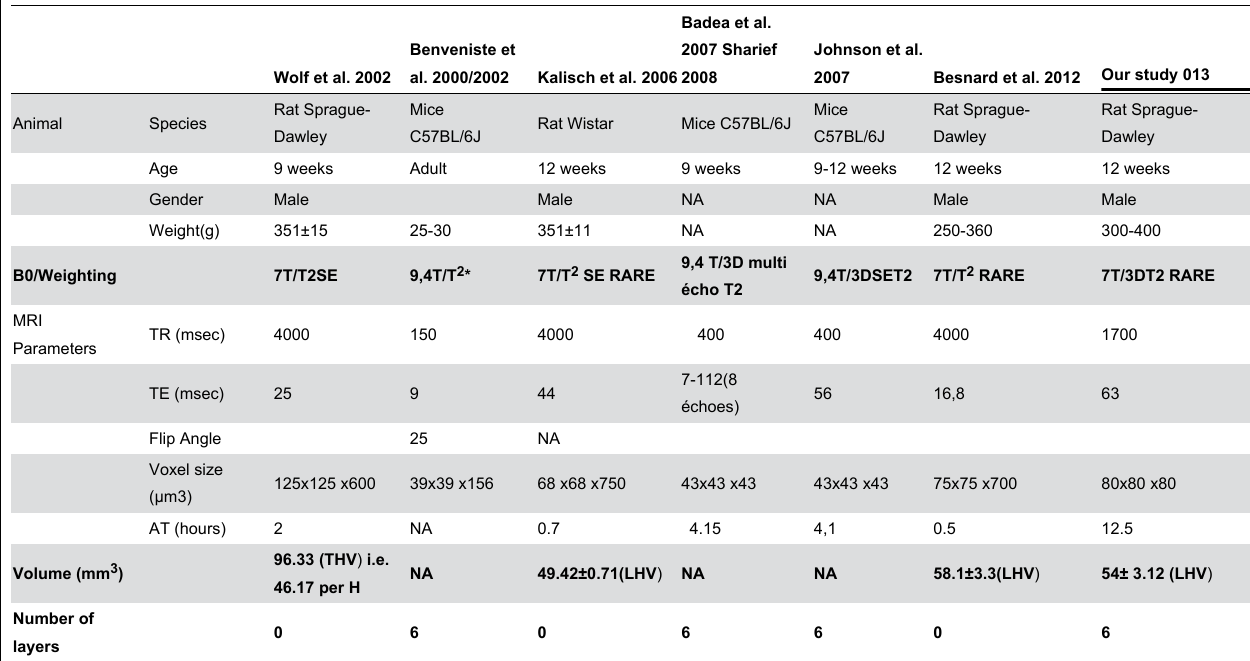
Table 3. Review of MRI parameters.